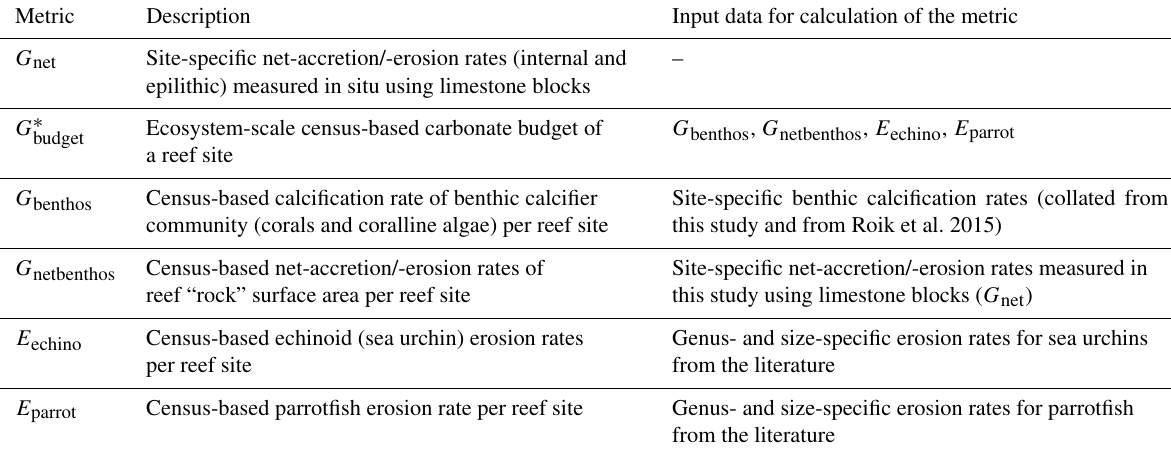
Table 1. Glossary of reef growth metrics.